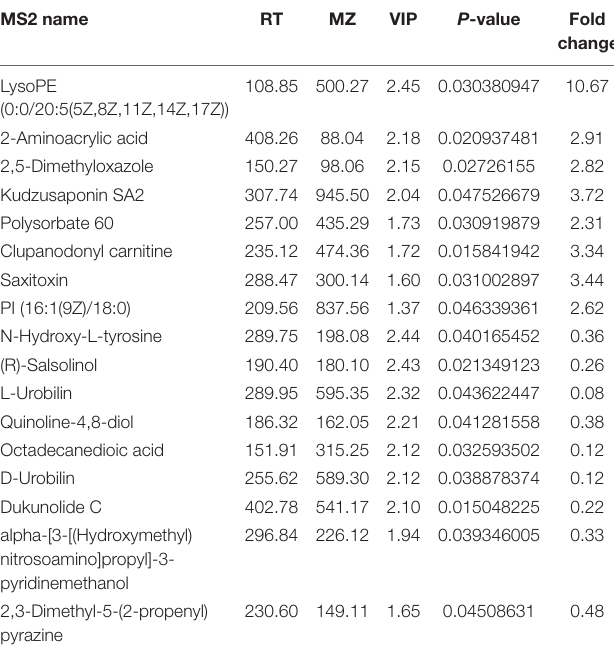
TABLE 2 | The top 20 most significantly changed metabolites in GDM rats treated with lose-dose probiotics supplements vs. GDM rats.